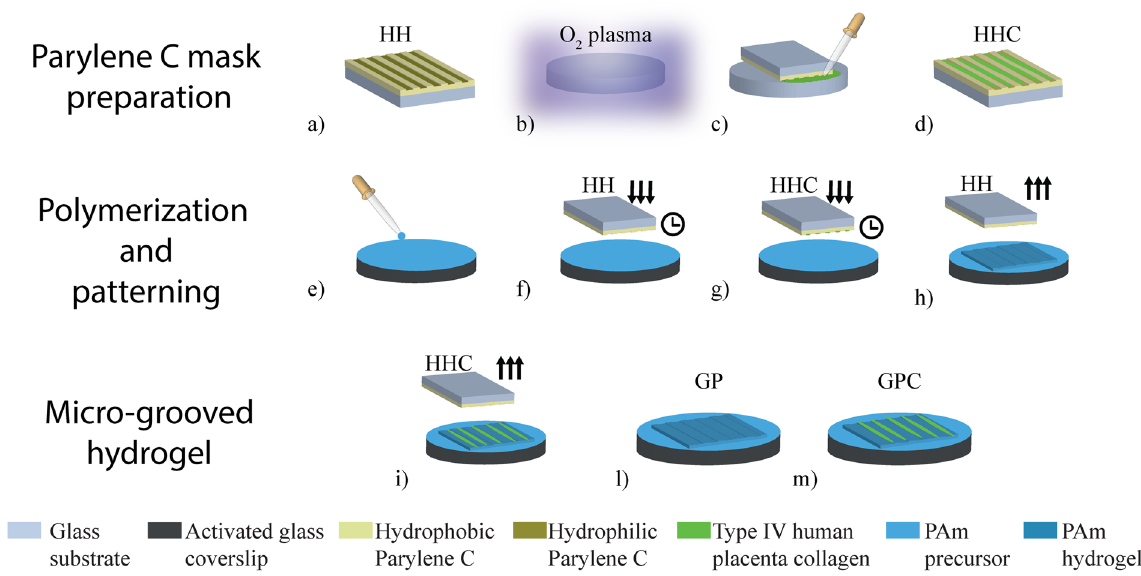
Figure 2. Parylene C preparation and polyacrylamide hydrogel patterning process. HH masks were prepared using standard lithographic process ( a ). Glass was activated using oxygen plasma ( b ) and protein solution was flushed in HH mask microchannels in order to pattern the template and have selectively protein only in Parylene C hydrophylic trenches ( c ) creating HHC masks ( d ). PAm solution was pipetted into silanized coverslips ( e ) and HH and HHC masks were placed upside-down on PAm pre-polymer ( f , g ). After gelation time, masks were removed ( h , i ) and PAm hydrogel was patterned either topographically (GP) (l ) and biochemically with collagen (GPC) ( m